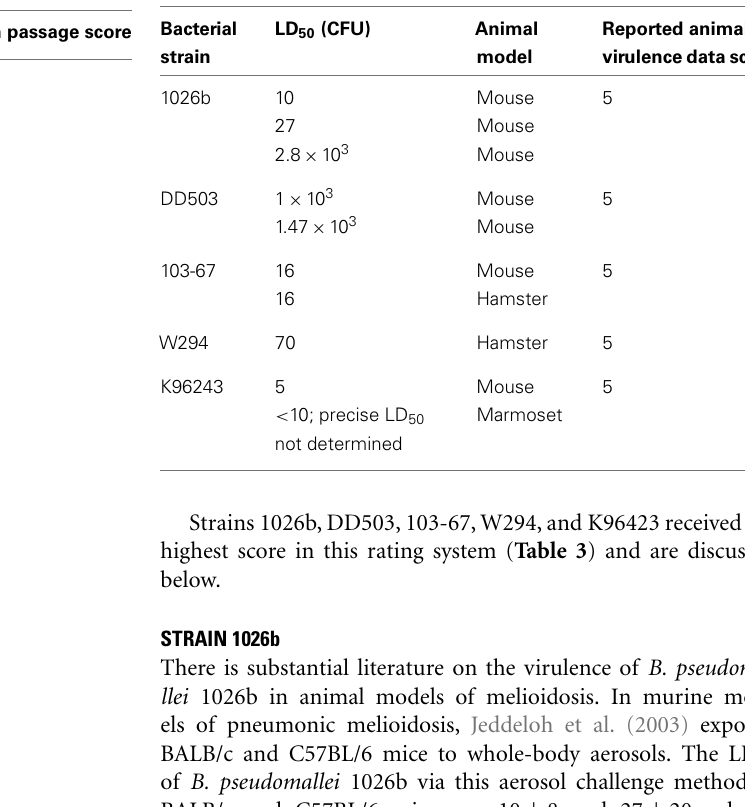
Table 2 | Burkholderia pseudomallei strains that may be obtained with low passage number.